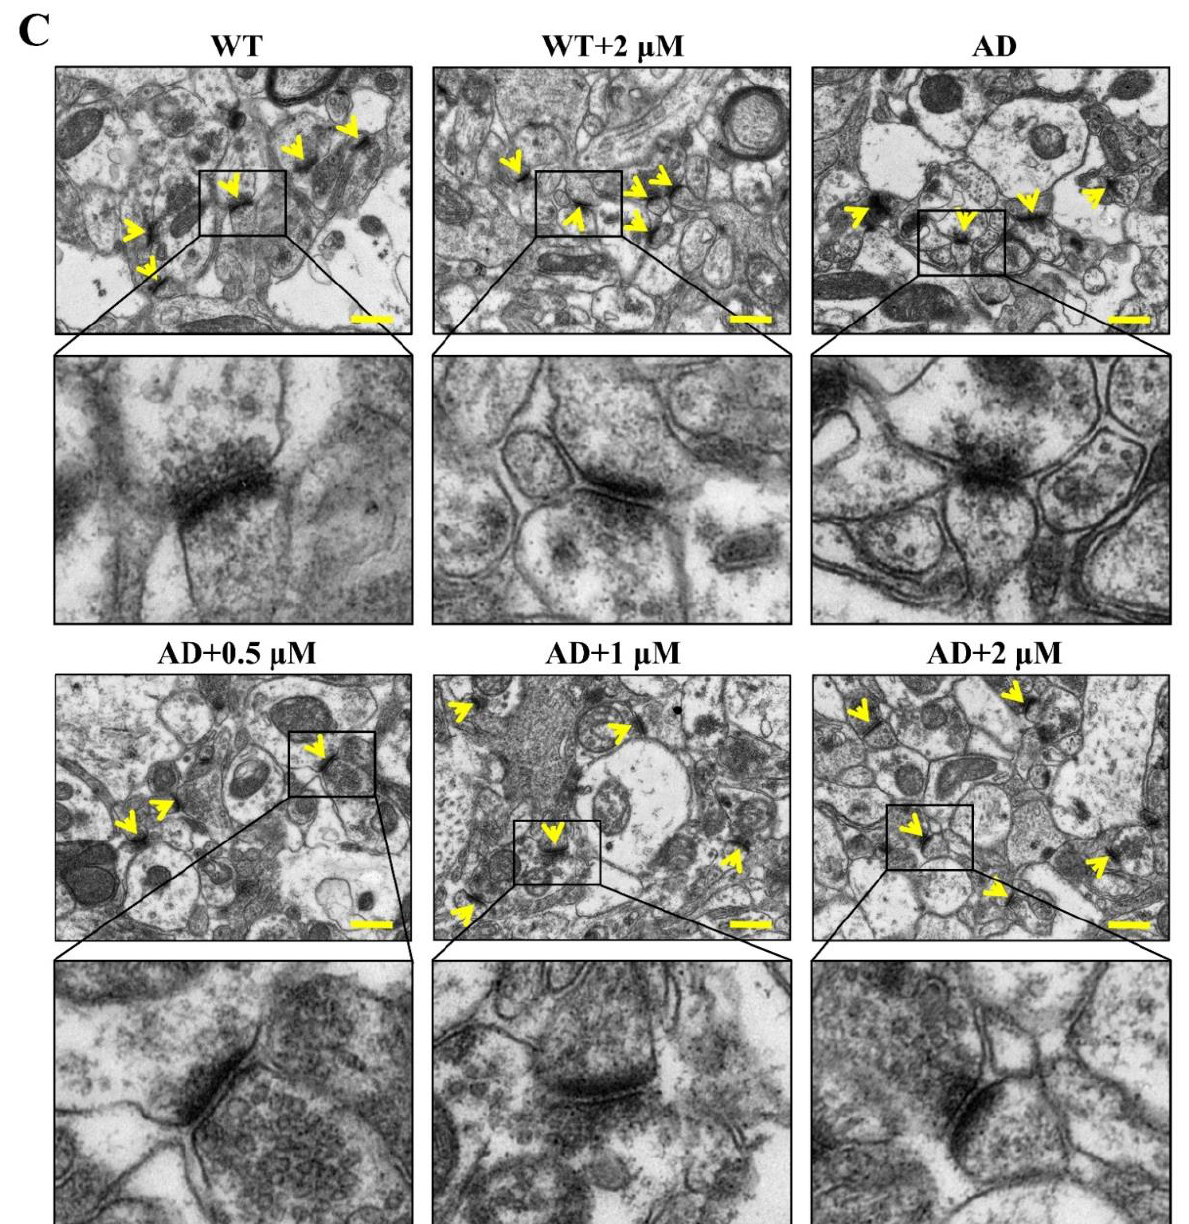
Figure 3. Ebselen increased synaptic protein levels and repaired synaptic morphologies in AD mice brains: ( A , B ) Representative Western blot analysis of PSD95. The quantitative results were normalized by GAPDH (* p < 0.05 vs. AD group; n = 3). ( C ) Representative transmission electron microscopic images of synapses (yellow arrows) in the cerebral cortex of mice. (Scale bar: 5.0 µ m; n =